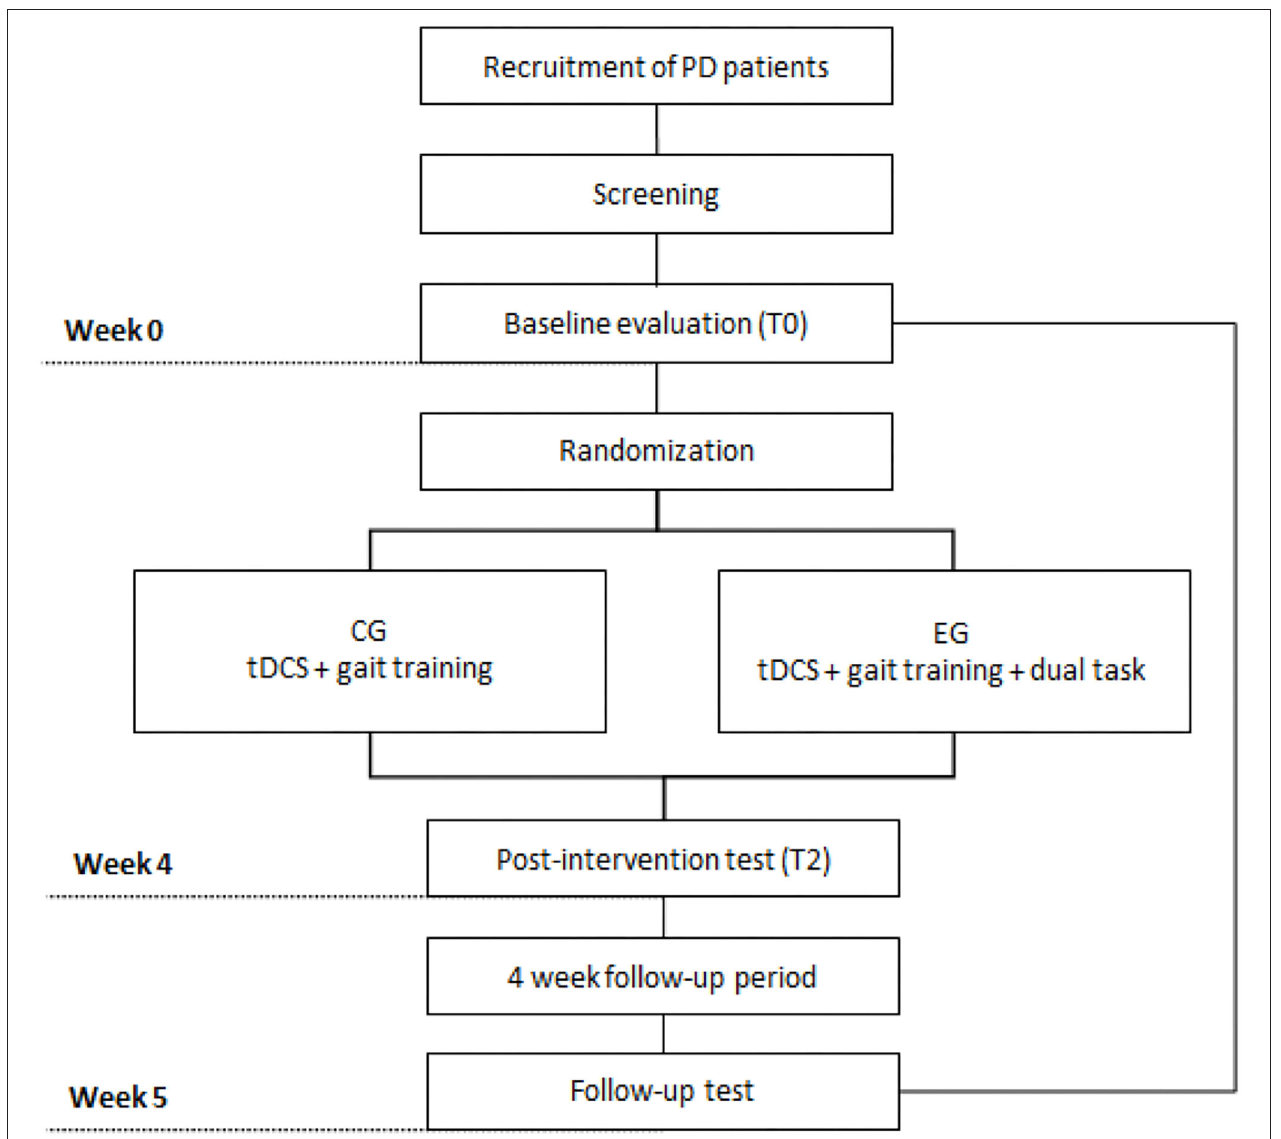
FIGURE 2 | Design of the study. Legends: PD, Parkinson’s disease, CG, Control Group, EG, Experimental Group, tDCS, transcranial direct current stimulation.